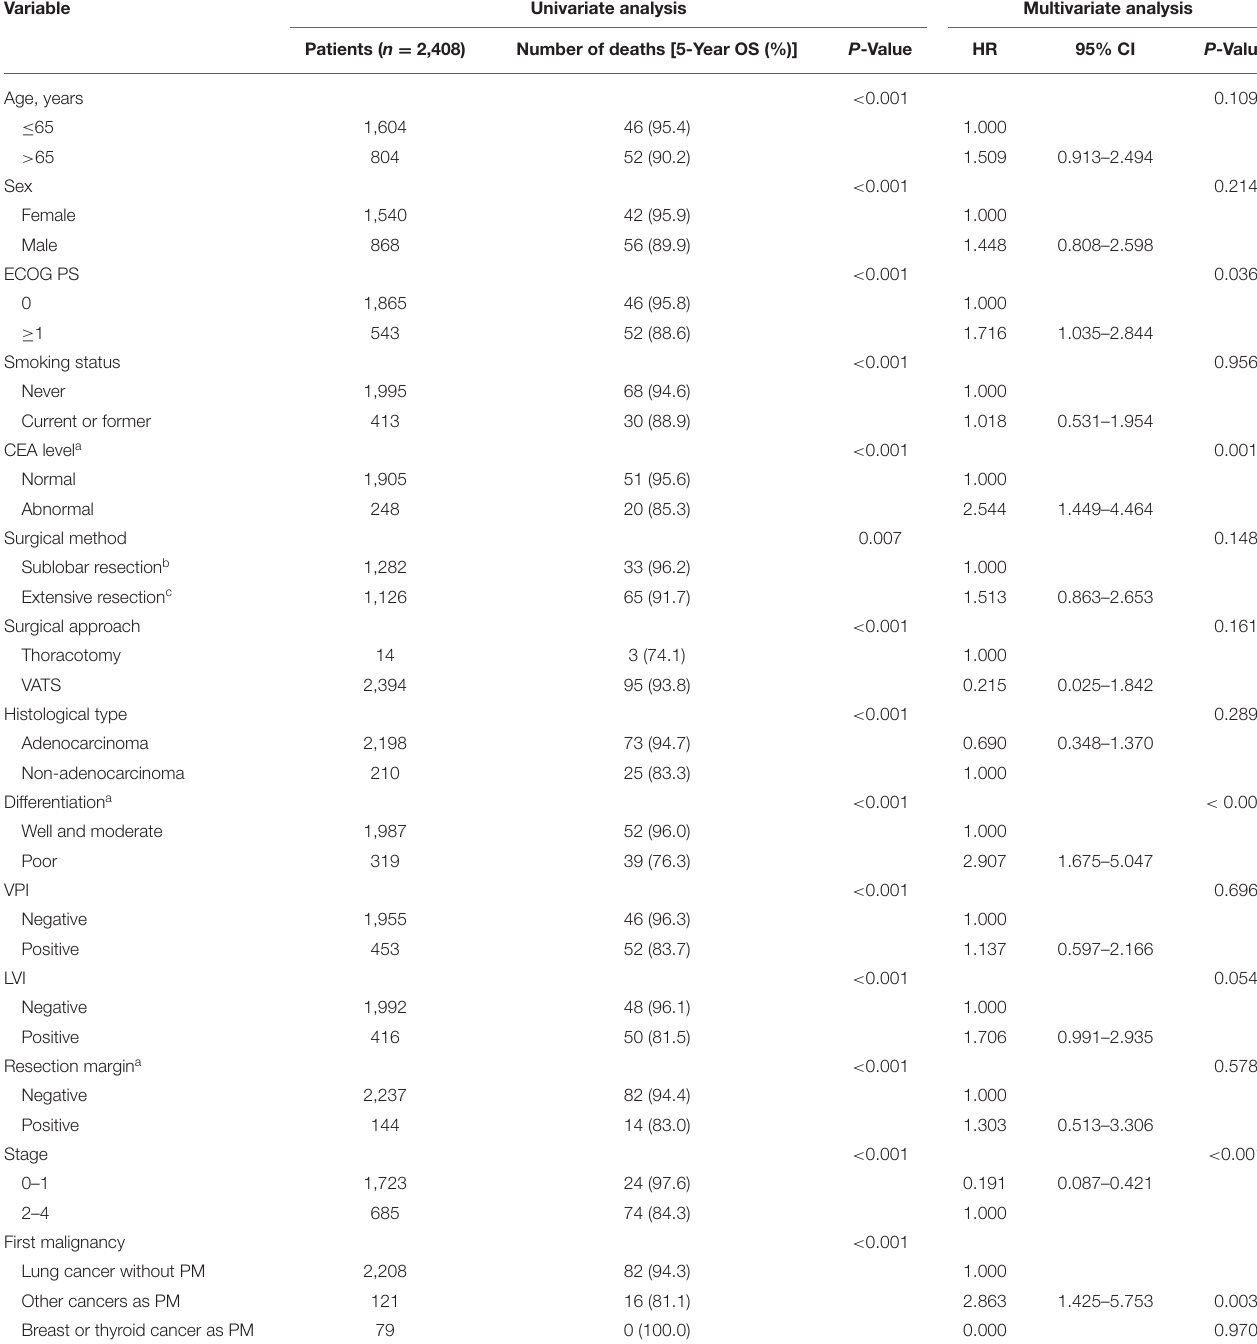
TABLE 4 | Univariate and multivariate analyses of clinicopathological features and overall survival. Variable Univariate analysis Multivariate